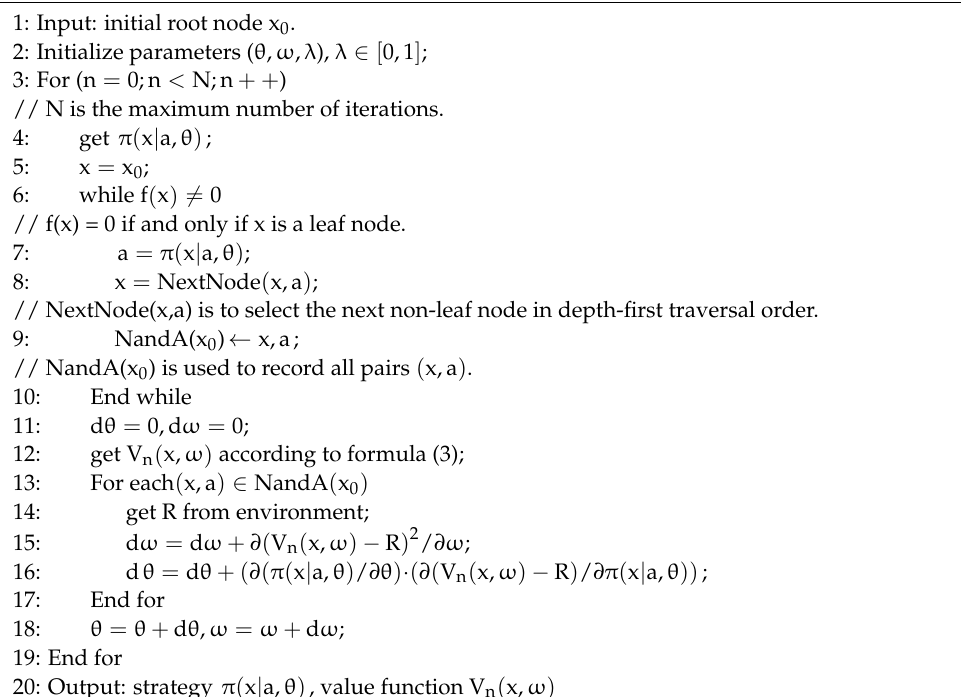
Algorithm 1: Decision Tree Construction Algorithm